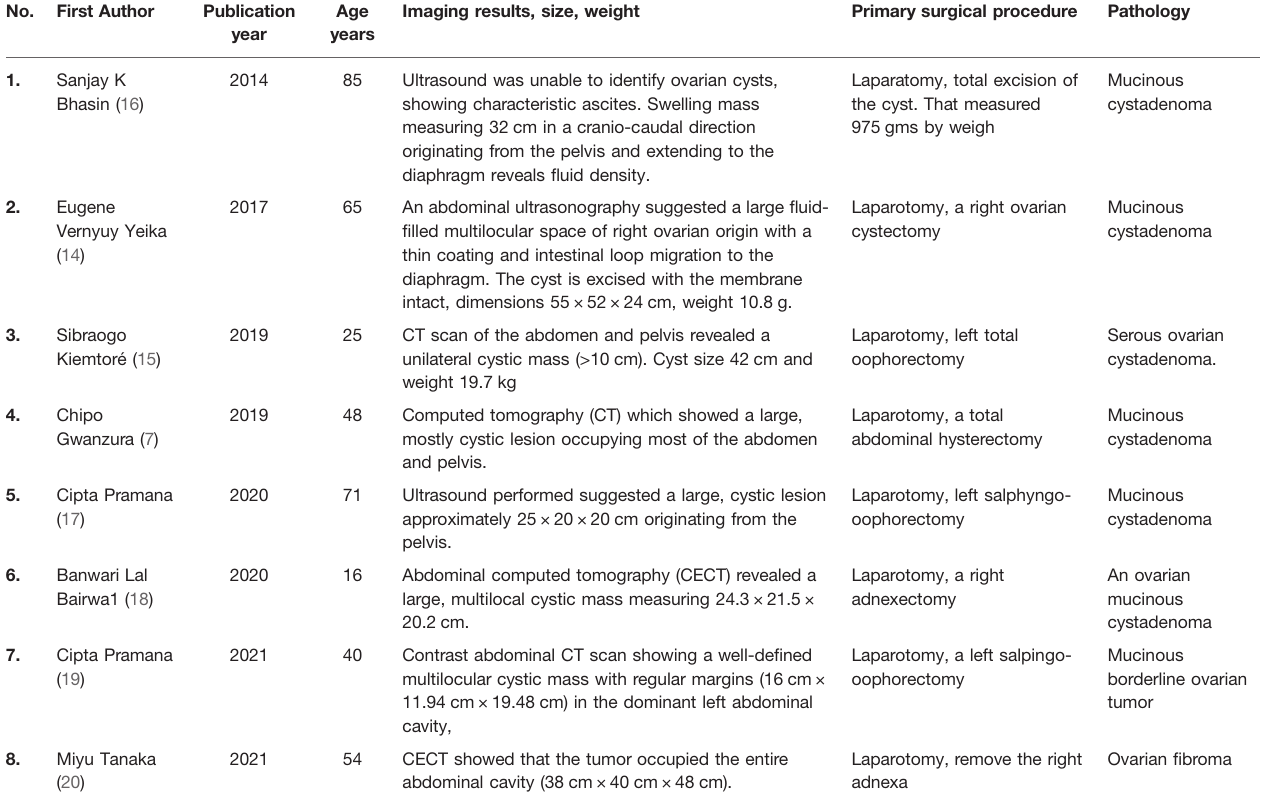
TABLE 1 | Short literature